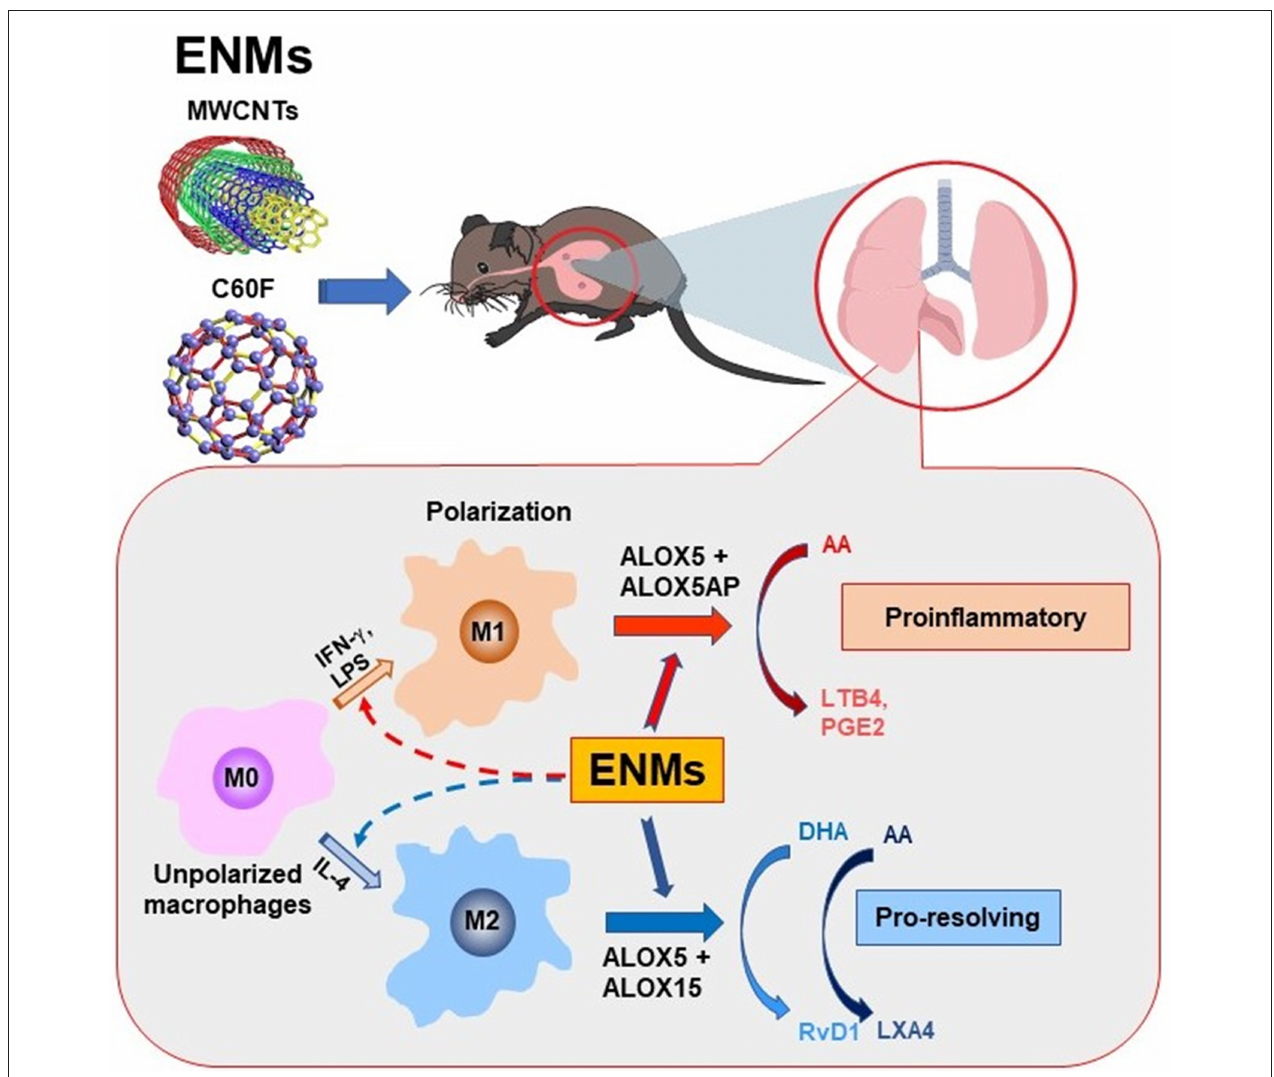
FIGURE 12 | Induced biosynthesis of specialized LMs through M1- and M2-associated pathways. Polarization of M1 and M2 macrophages alters their ALOX pathways for the biosynthesis of proinflammatory LMs or SPMs and, thereby, regulate the initiation and resolution of neutrophilic inflammation in a time-dependent manner. In this model, exposure to inflammatogenic and fibrogenic ENMs, such as fiber-like MWCNTs, induces the production and secretion of LTB4, PGE2, and other proinflammatory LMs from M1 macrophages via induced expression of ALOX5 and ALOX5AP, which stimulates the rapid initiation of neutrophil infiltration and proinflammatory cytokine secretion. The continued presence of ENMs in the lung stimulates the production of RvD1 and other SPMs from M2 macrophages by inducing ALOX5 and ALOX15, which converts the lung environment from being proinflammatory to pro-resolving, thereby promoting the resolution of neutrophilic